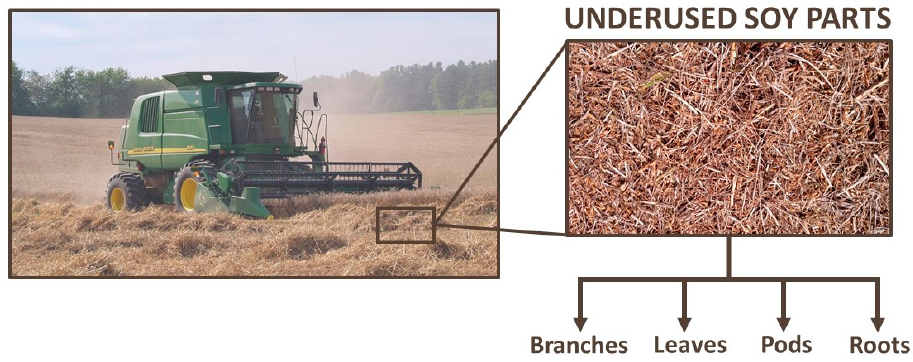
Figure 2. World soybean production 2000–2020, in million metric tons.